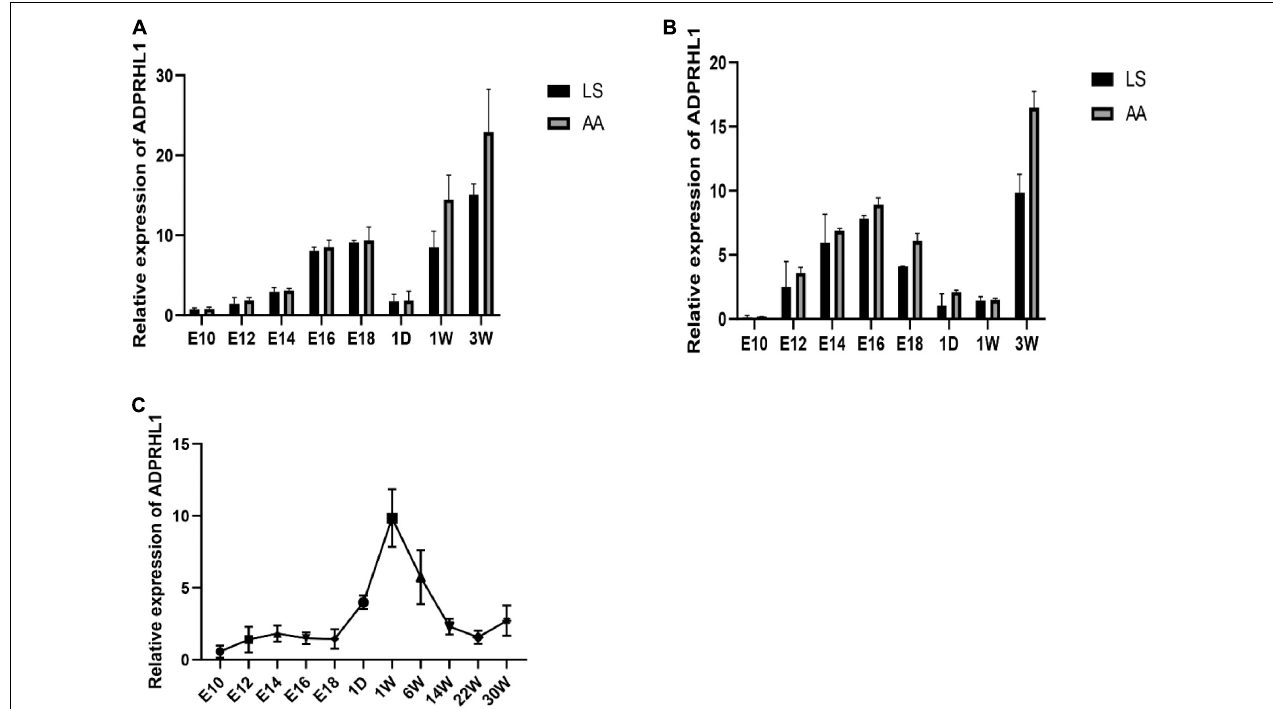
FIGURE 3 | Relative expression patterns of ADPRHL1 . (A) Relative expression patterns of ADPRHL1 in the leg muscle in LS and AA chickens tissues at 10, 12, 14, 16, and 18 embryo and 1 day, 1 week, and 3 weeks of age. LS, Lushi chicken; AA, Arbor Acres broilers. n = 6. (B) Relative expression patterns of ADPRHL1 in the breast muscle in LS and AA chickens tissues at 10, 12, 14, 16, and 18 embryonic days and 1 day, 1 week, and 3 weeks of age. LS, Lushi chicken; AA, Arbor Acres broiler; n = 6. (C) Relative expression patterns of ADPRHL1 in the leg muscle in GS chickens tissues at 10, 12, 14, 16, and 18 embryo and 1 day, 1 week, 6 weeks, 14 weeks, 22 weeks, and 30 weeks of age. GS, Gushi chicken; n =